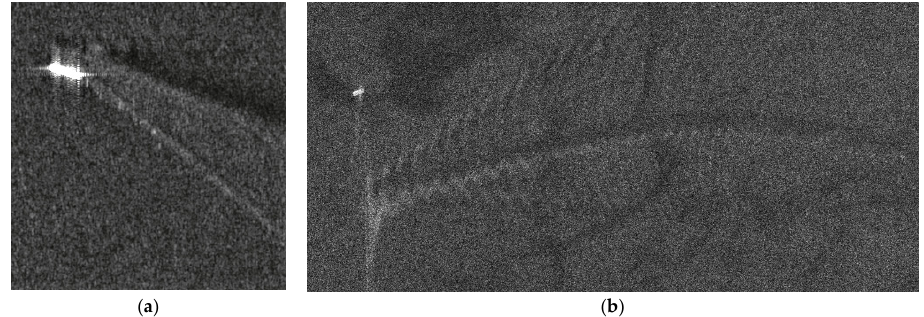
Figure 2. ( a ) Stripmap VV-polarized Sentinel-1 image over the Gulf Rotterdam on 27 July 2016; ( b ) Stripmap VV-polarized COSMO/SkyMed image over the Gulf of Naples, Italy, on 5 August 2011. The Sentinel-1 image resolution is 23 m, whereas the COSMO/SyMed image resolution is 3 m.